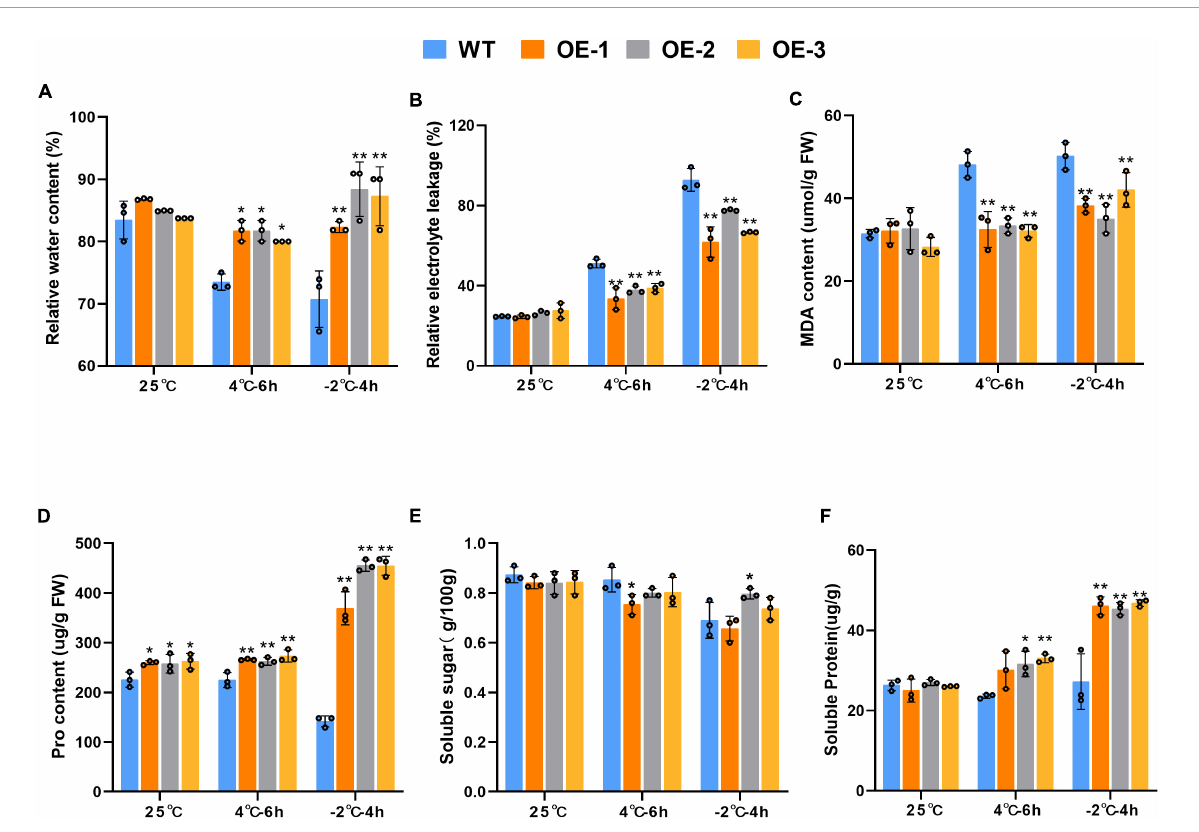
FIGURE5 Physiological changes of wild-type in wild-type and SiLEA4-overexpressing transgenic tomato plant lines (OE-1, OE-2, and OE-3) under cold stress. (A) RWC (%), (B) REL (%), (C) MDA content, (D) pro content, (E) soluble sugar, (F) soluble protein. Data are means ± SD of three replicates. Asterisk(s) indicate significant difference between the wild-type and transgenic plants: * P < 0.05 and ** P < 0.01.